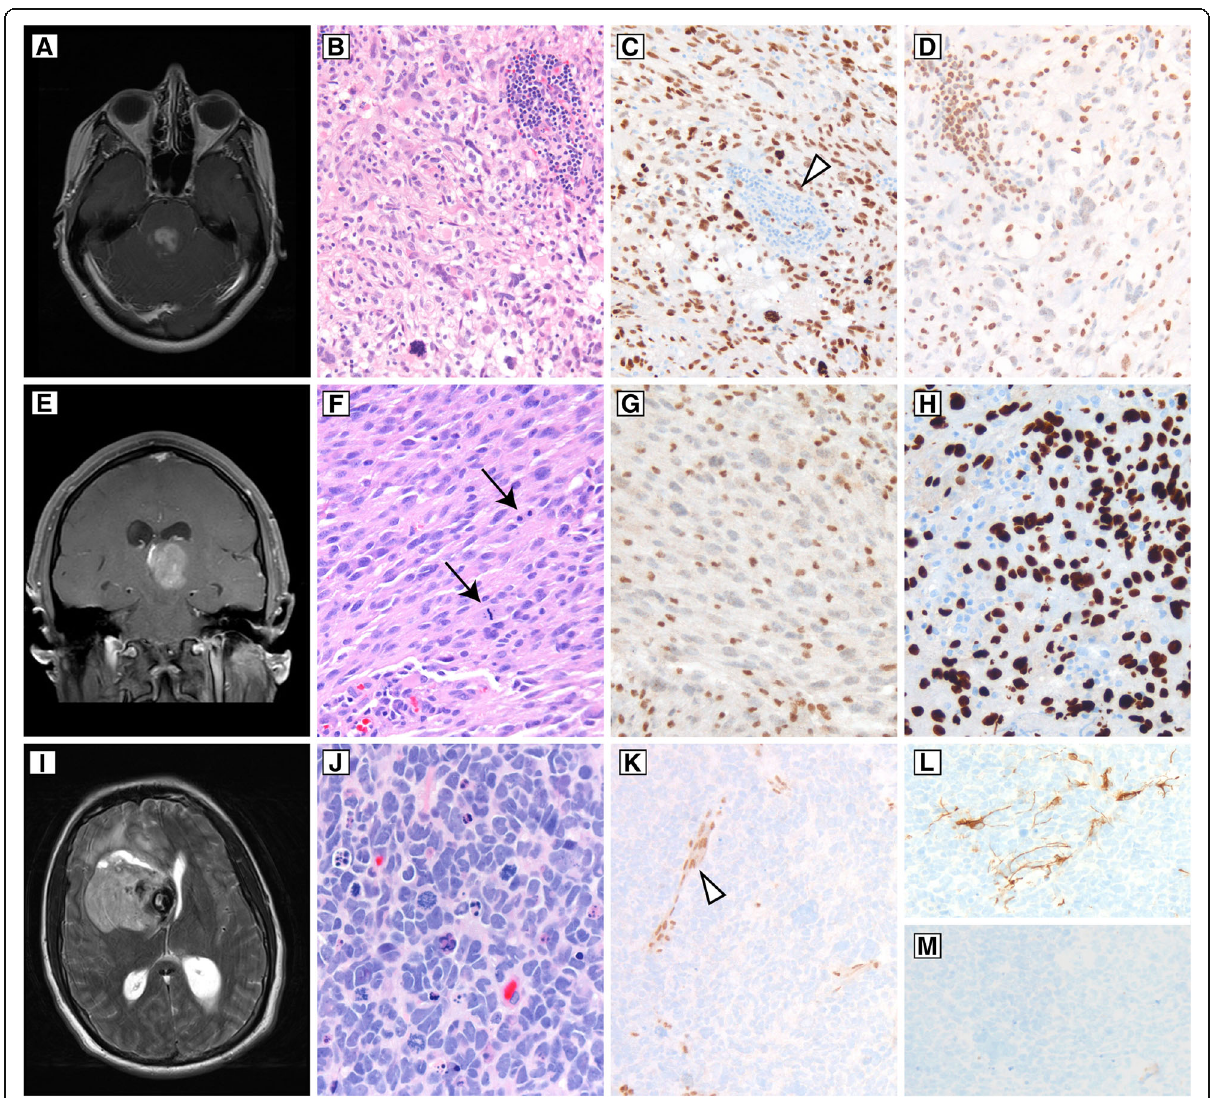
Fig. 5 Examples of histone H3 mutant gliomas. a Post-contrast T1-weighted imaging of an enhancing pontine mass occurring in a 33-year-old woman. Biopsy showed a markedly pleomorphic astrocytoma with frequent mitotic figures and prominent perivascular inflammation ( b ). Tumor cell nuclei were positive for histone H3 K27M mutant protein ( c ), while inflammatory cells were negative for this marker (white arrowhead). Immunohistochemistry for trimethylated histone H3 is negative in tumor nuclei ( d ), and appropriately stains inflammatory cells. e Post-contrast T1-weighted imaging of a left thalamic tumor occurring in a 31-year-old man who presented with headaches. Sections showed an astrocytic neoplasm with mitotic activity (black arrows) ( f ). ATRX was absent in tumor cell nuclei, and stained a background population of macrophages and microglial cells ( g ). An immunostain for H3 K27M was positive in tumor nuclei ( h ), supporting the diagnosis of diffuse midline glioma, H3 K27M-mutant, WHO grade IV. ( i ) T2-weighted imaging of a right frontal cerebral hemispheric tumor in a 35-year-old man who presented with headaches. Sections showed a tumor with brisk mitotic activity, frequent apoptotic cells, high nuclear to cytoplasmic ratios, and nuclear molding ( j ). ATRX was negative in tumor cell nuclei ( k ), with preserved staining in the endothelial cells (white arrowhead). GFAP showed only focal staining ( l ), and OLIG2 was completely negative ( m ). p53 (not pictured) was strongly positive. Sequencing of this tumor showed wildtype IDH1 and IDH2 , and a further sequencing study revealed an H3F3A G34R